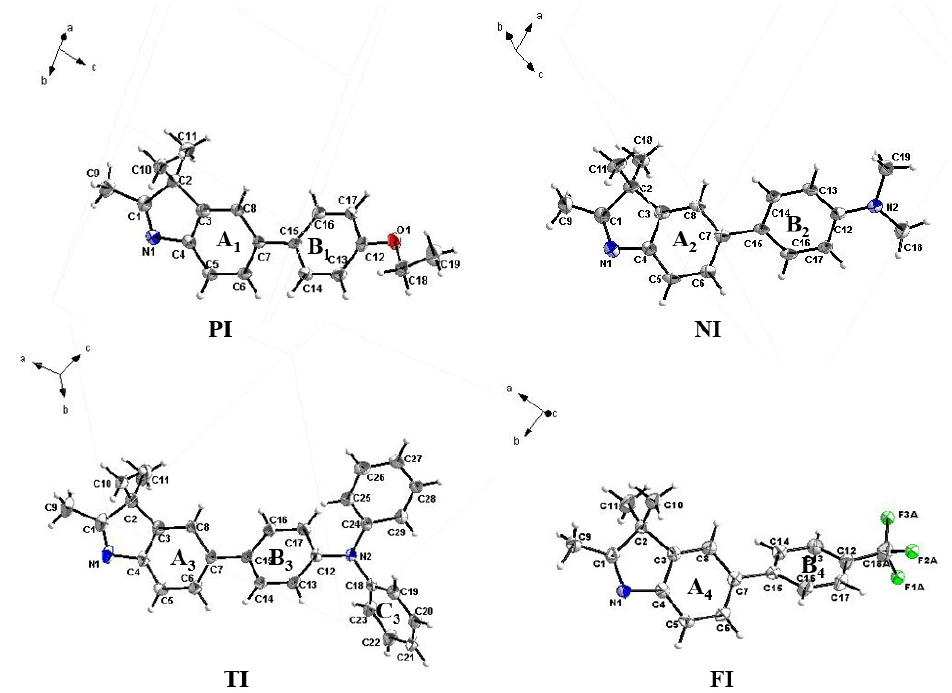
Figure 6. Molecular structure (ORTEP diagram) of PI , NI , TI and FI.